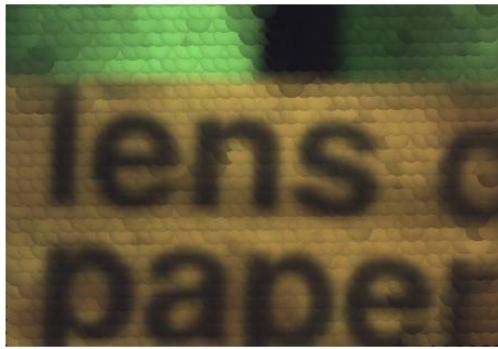
Figure 10. The rendering image corresponding to the captured raw light-field